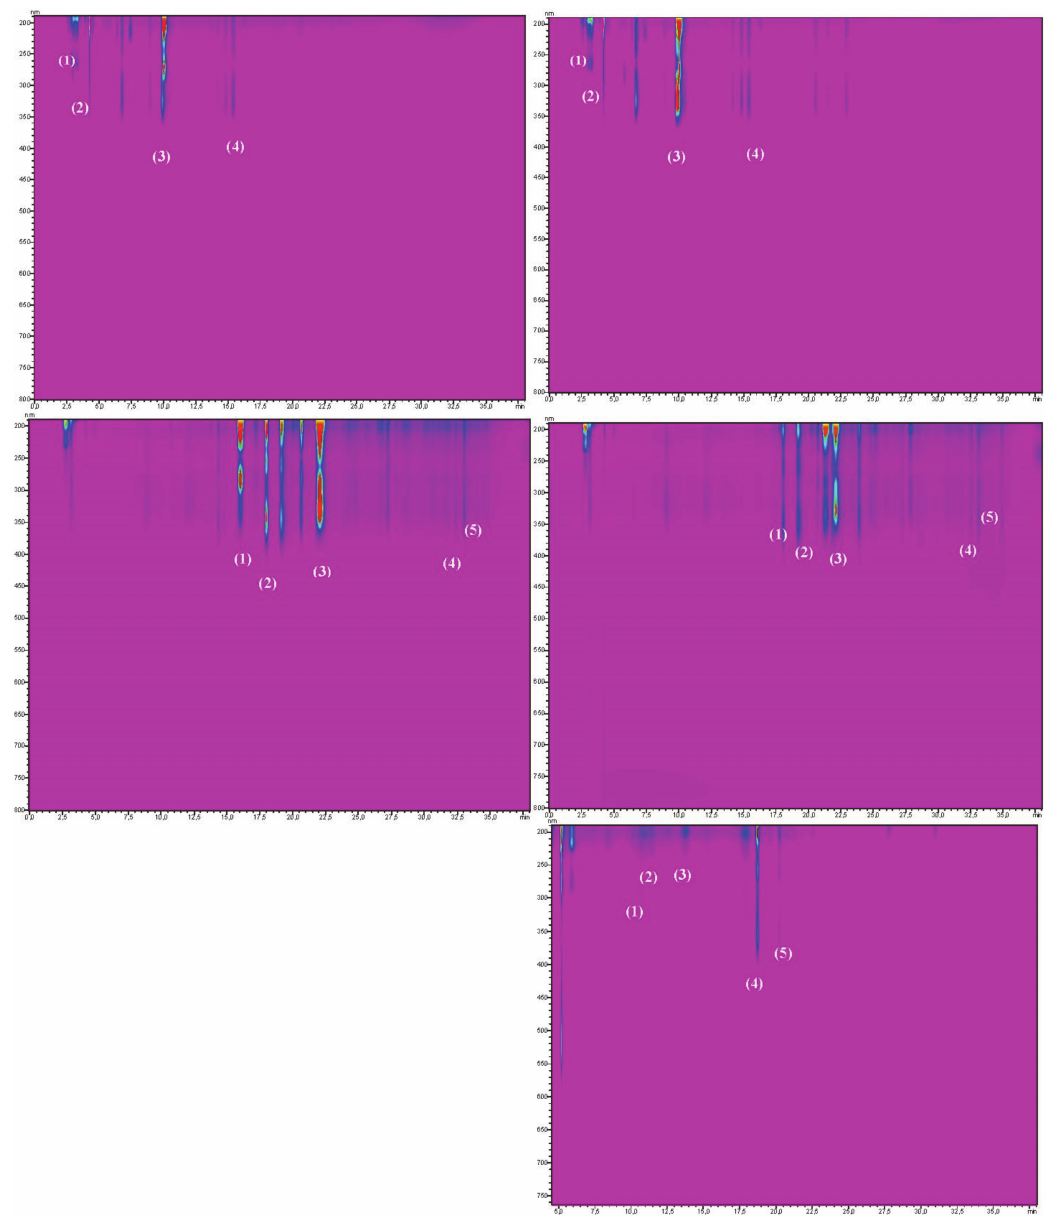
Figure 4. Picture showing spectra area and retention times in black locust [A] and bristly locust [B] for phenolic acids [A1] and [B1]; flavonols [A2] and [B2]; and anthocyanins [B3]. A similar relationship was observed with daisy flowers. Pink daisy flower species contained 18.63 g / 100 g FW and white daisy flowers contained 15.97 g / 100 g FW [25]. Polyphenols are one of the most important and pro-healthy secondary metabolites produced by plants. They function in plant flowers to make the flowers more attractive to pollinating insects [26]. Polyphenols are connected with floral nectar and pollen production as well as color recognition by pollinator insects [27]. In the present experiment, we observed significantly more total polyphenols in the pink flower species (bristly locust) compared to the white flower species (black locust) ( p < 0.0001) in both experimental years ( p = 0.0017). Similar results were observed with heathier flowers. Bright flower Erica species contained half of the total polyphenols (42.9 mg / g DW, dry weight) compared to pink flower Erica species (81.0 mg / g DW) [28]. Daisies with white flowers contained 0.31 mg / g FW of total polyphenols and pink daisies contained 0.44 mg / g FW [25]. In both years of the experiment, greater and significant total